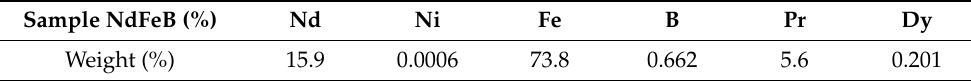
Table 1. Chemical analysis of powder.